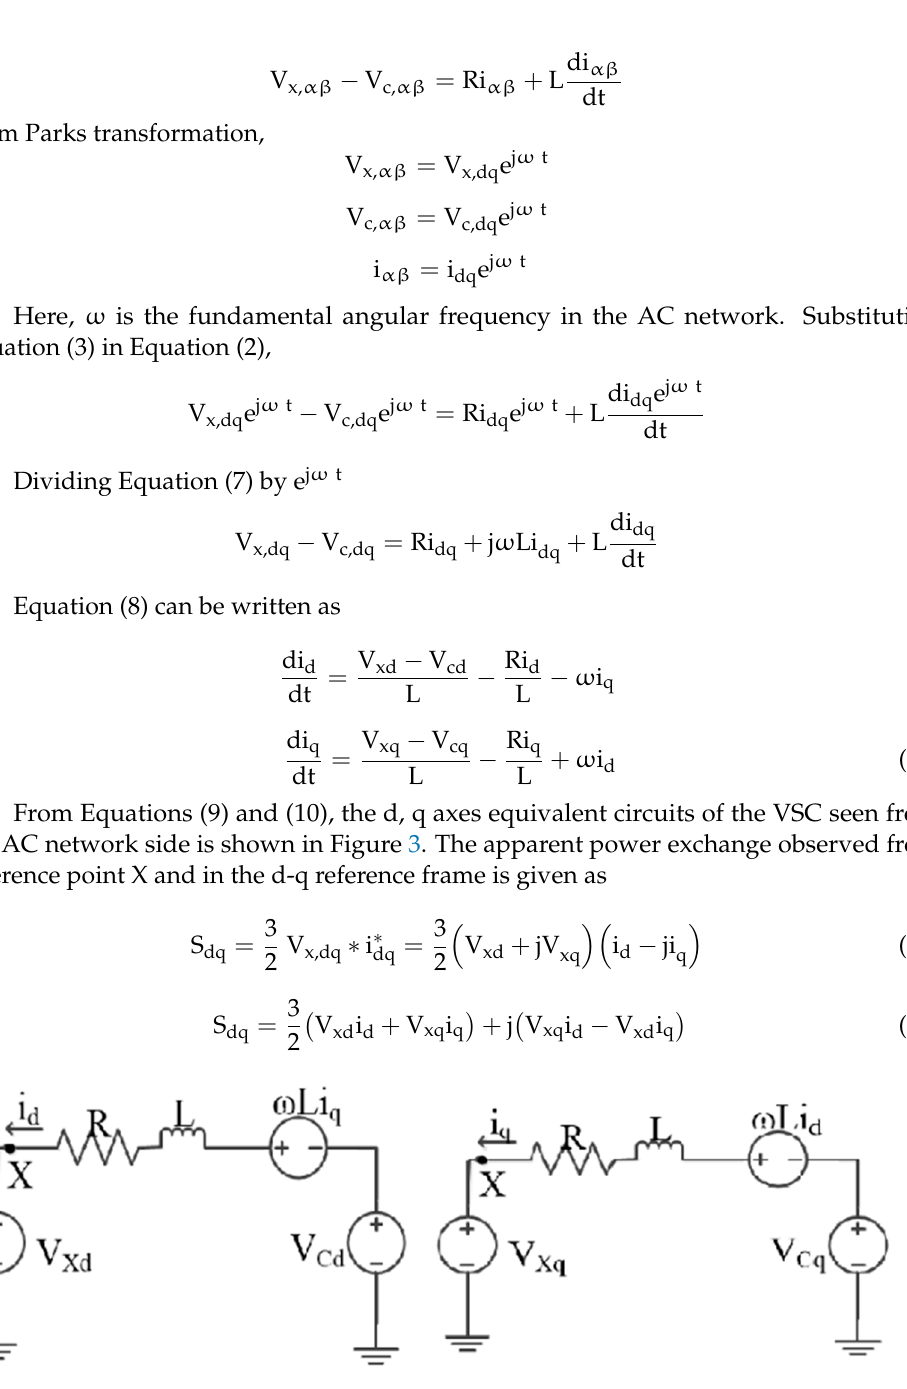
Figure 3. Equivalent circuit of d and q axes of VSC.